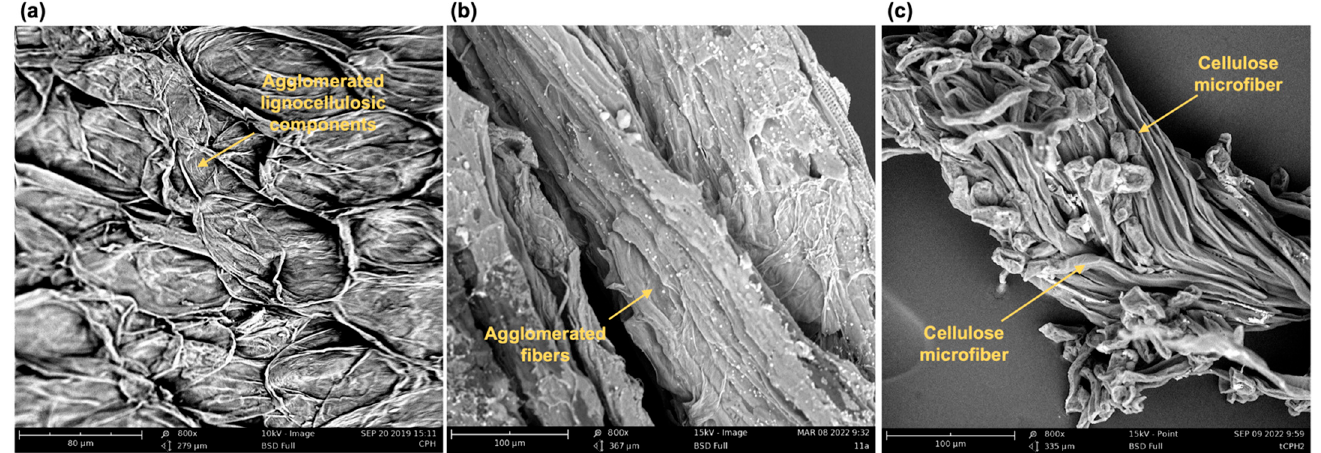
Figure 4. Microscopic structure of ( a ) CPH fiber, ( b ) control sample (tCPHnpe), and ( c ) tCPH cellulose microfibers. All SEM micrographs used 800× magnification .